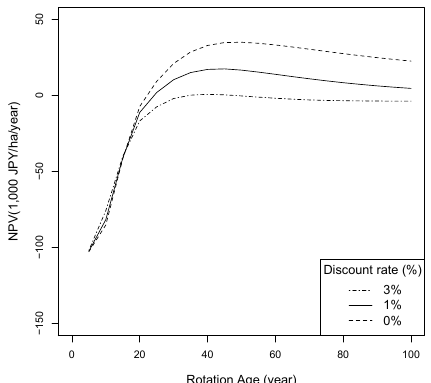
Figure 4. The relationship between the discount rate and the NPV of saw log production at a plantation density of 3000 trees/ha.